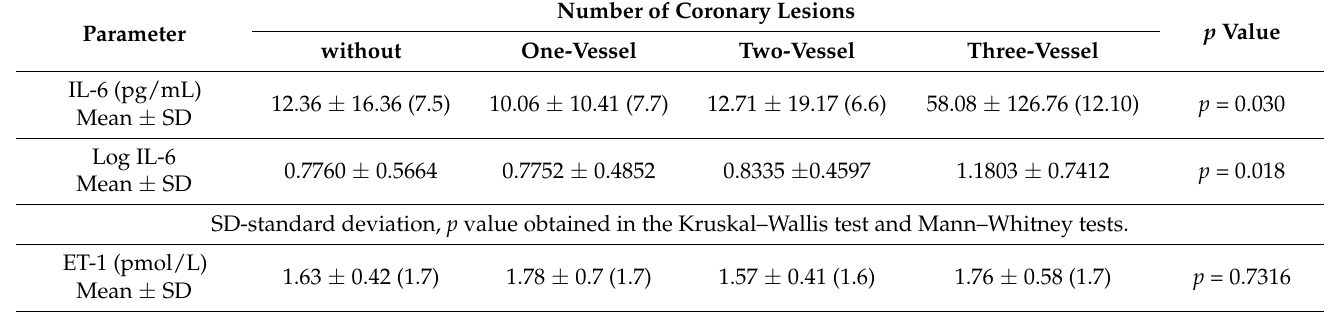
Table 2. Correlation between serum IL-6 and ET-1 levels and the degree of coronary involvement, explained by the number of coronary lesions.